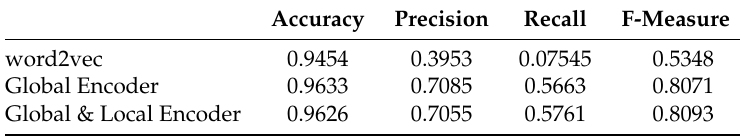
Table 3. Results of three different encoders for geographic-named entities